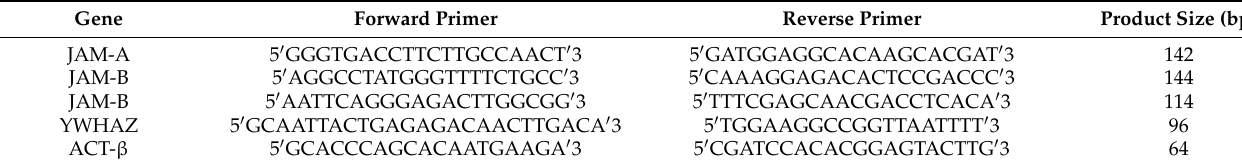
Table 1. Primers sequences and expected product sizes (base pairs).